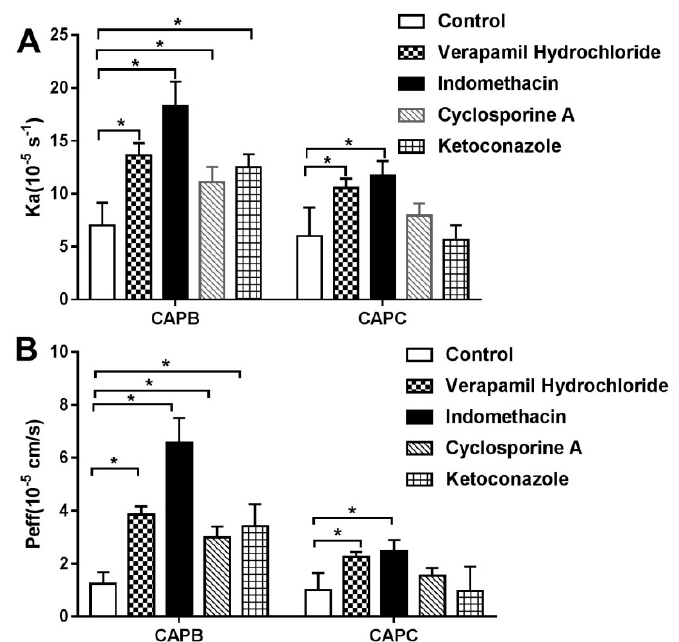
Figure 5. The effect of different factors on intestinal absorption of capilliposide B (CAPB) and capilliposide C (CAPC). The data are presented as absorption rate constants (ka, s − 1 ) values (B) and effective permeability (P eff , cm/s). P-glycoprotein (P-gp) inhibitor (verapamil hydrochioride); multidrug resistance-associated protein 2 (MRP2) inhibitor (indomethacin); and the co-inhibitor of P-gp, MRP2 and cytochrome P450 protein 3A4 (CYP3A4) (cyclosporine A); and CYP3A4 inhibitor (ketoconazole) on small intestinal absorption of CAPB ( A ) and CAPC ( B ). p < 0.05 (*), in comparison with control. All the results are expressed as mean ±S.D. (n = 3).